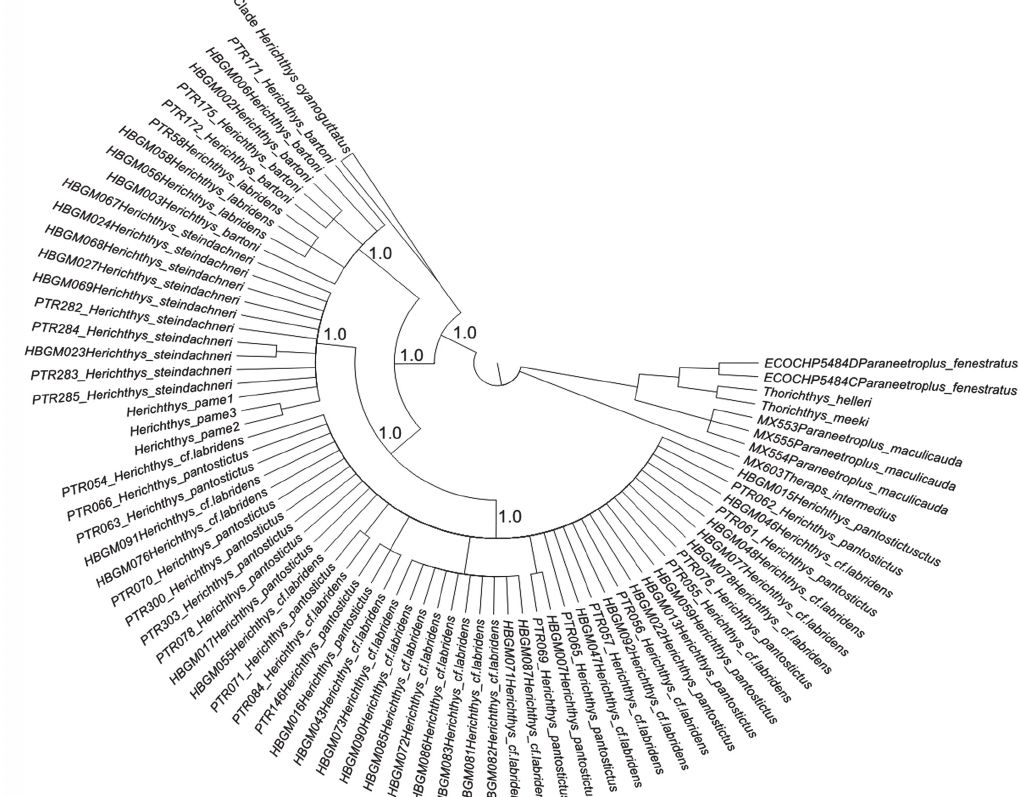
Fig. 3. Phylogenetic analysis of the Herichthys bartoni species group obtained from the Bayesian analysis of an approximately 652 bp fragment of the mitochondrial cytochrome c oxidase subunit I (DNA Barcode). Numbers above nodes are the Bayesian Posterior Probabilities (BPP) for the principal clades recovered in the analysis. The haplotypes of the species included in the H. cyanoguttatus species group were collapsed to facilitate